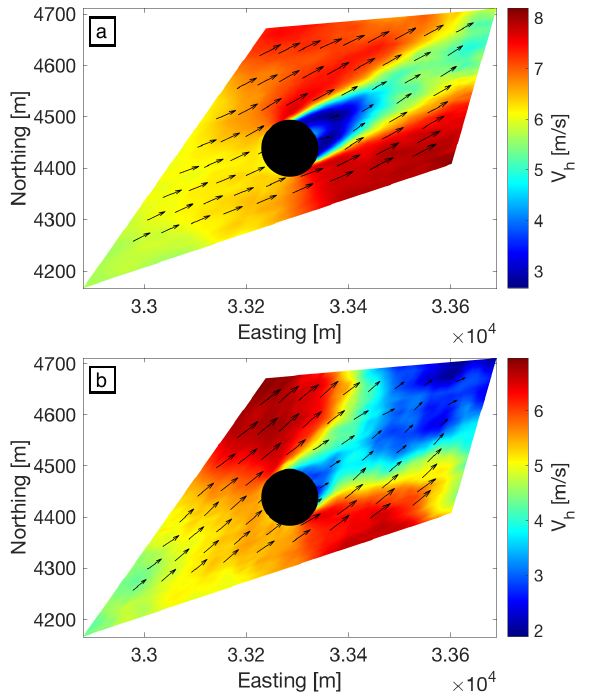
Figure 12. The wake in a horizontal plane observed with the dia- mond scan (10min averaged) performed by the long-range Wind- Scanner system for different atmospheric conditions: (a) stable conditions (measurements taken on 10 June 2015 from 22:20 to 22:30UTC); (b) unstable conditions (measurements taken on 11 June 2015 from 16:02 to 16:12UTC). The black circle repre- sents the rotor-swept area.